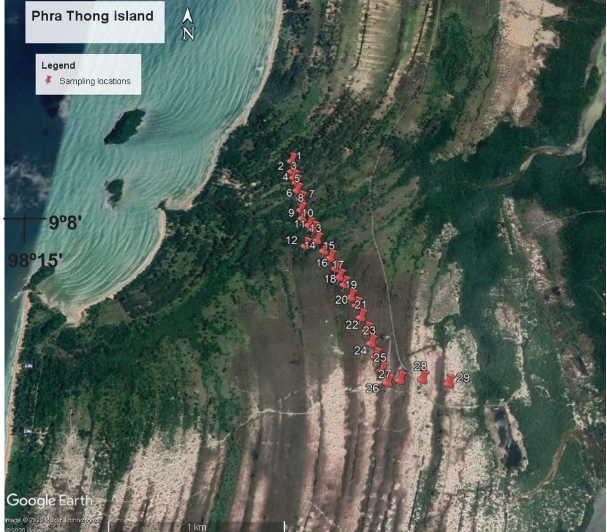
Figure 2. © Google Earth image showing locations of sampling points investigated for the 2004 Indian Ocean tsunami of the Phra Thong island described in this